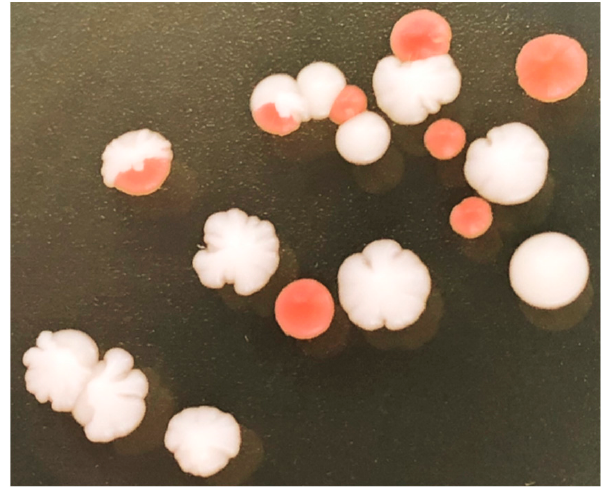
Figure A1. Heterozygous diploid S. cerevisiae EW01-GAL colonies after SCRaMbLE. A clear difference between red and white colonies is observed.